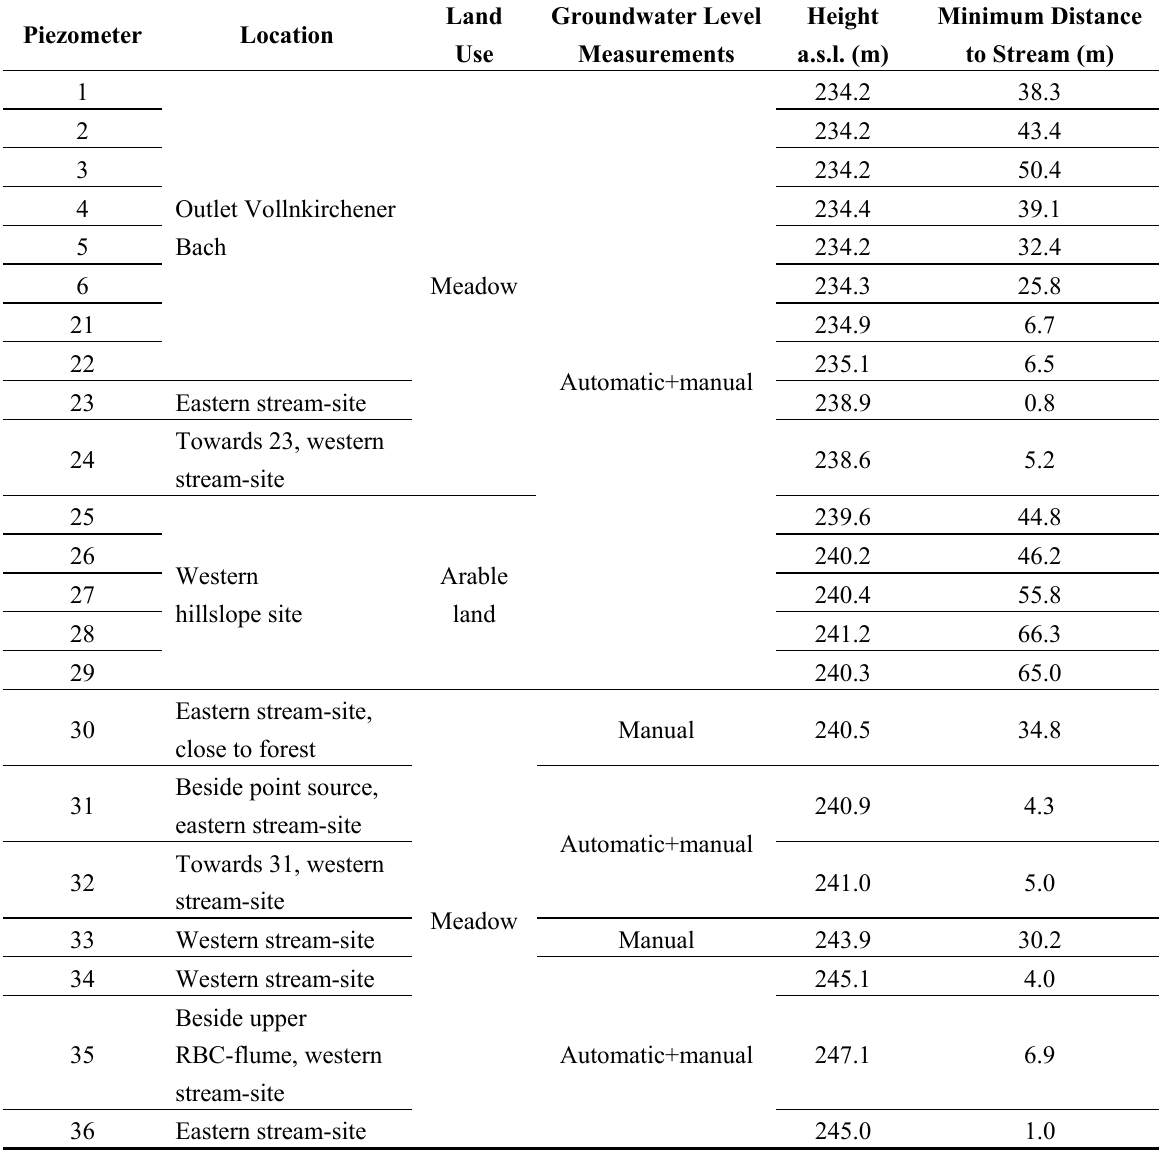
Table 1. General information on piezometers installed along the Vollnkirchener Bach.